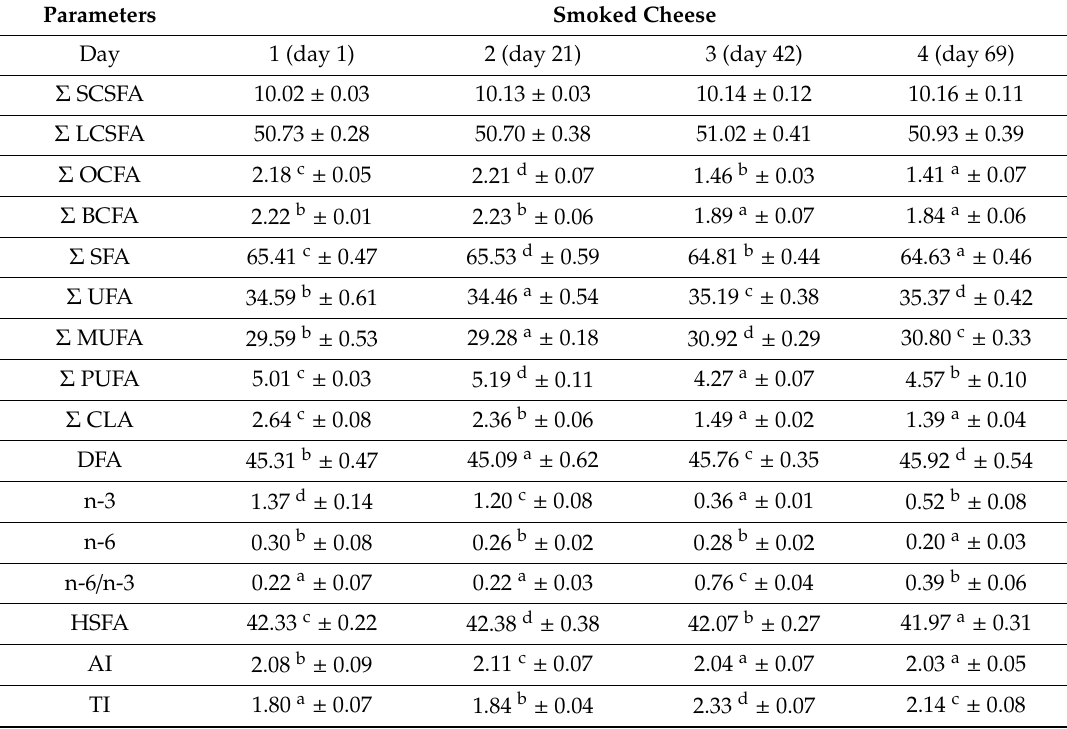
Table 2. Evolution of fatty acid profile [g / 100 g fatty acids] during storage of cheese for 69 days (mean ± SD, n =